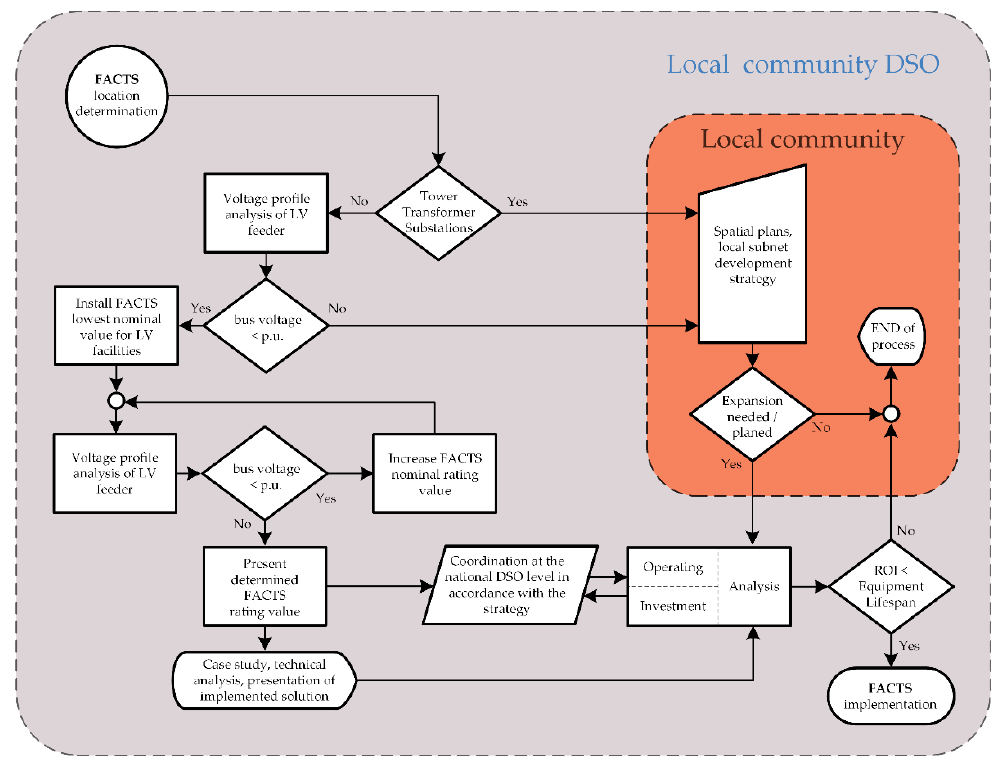
Figure 4. Algorithm for determining Flexible Alternating Current Transmission System (FACTS) implementation feasibility.